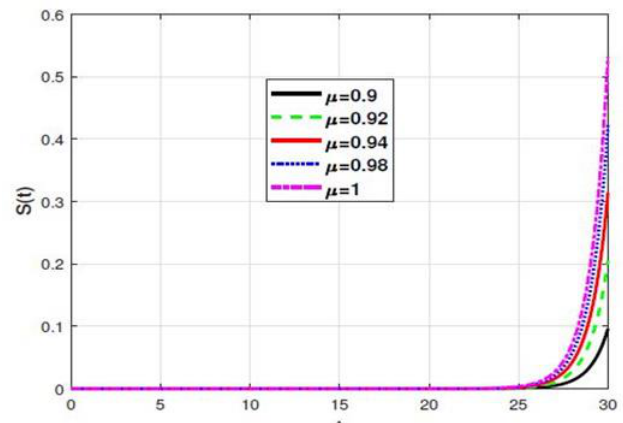
Fig. 1. Numerical experiments of susceptible class for various value of fractional order 𝛍.